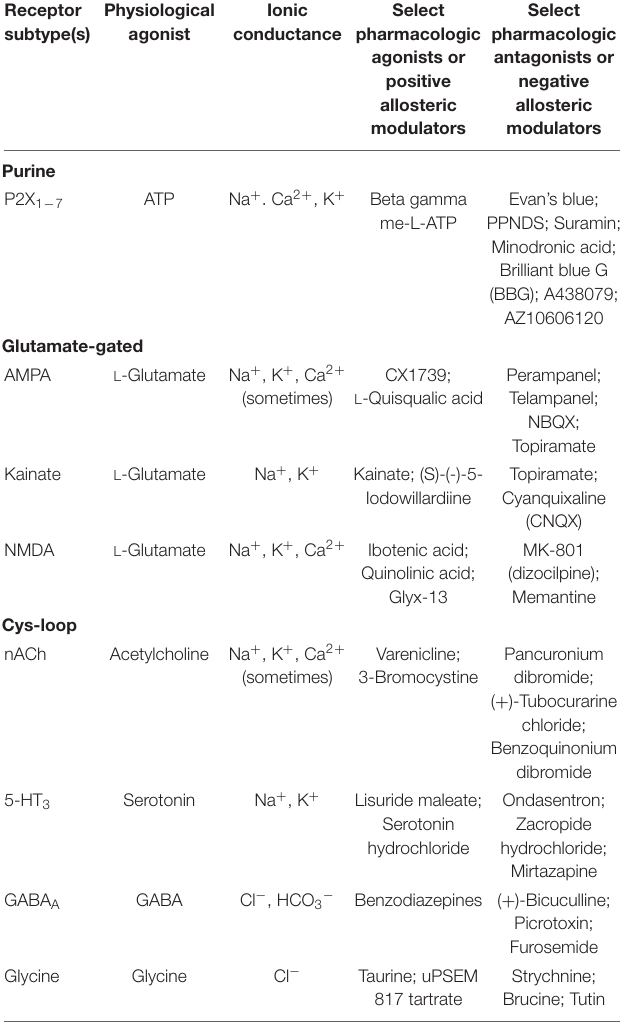
TABLE 1 | Ligand-gated ionotropic channel